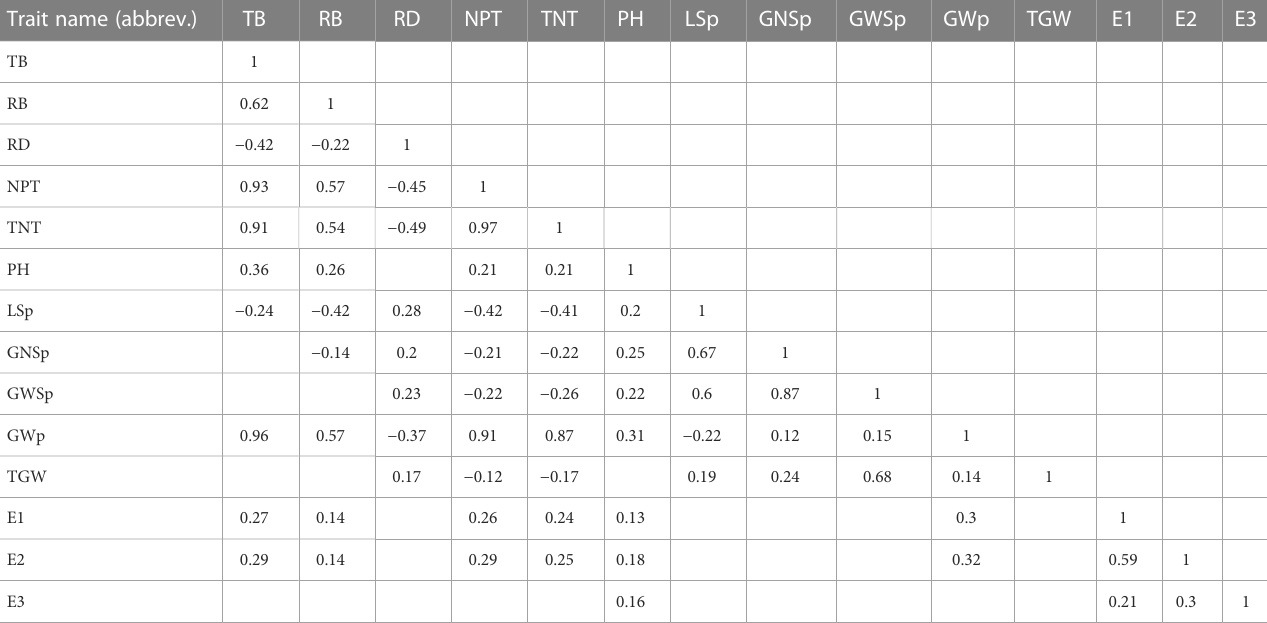
TABLE 4 Correlations between the studied traits of GWAS panel accessions ( P value < 0.05). Trait name